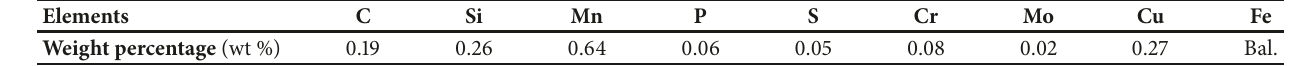
Table 1: The chemical structure of mild steel specimen (weight